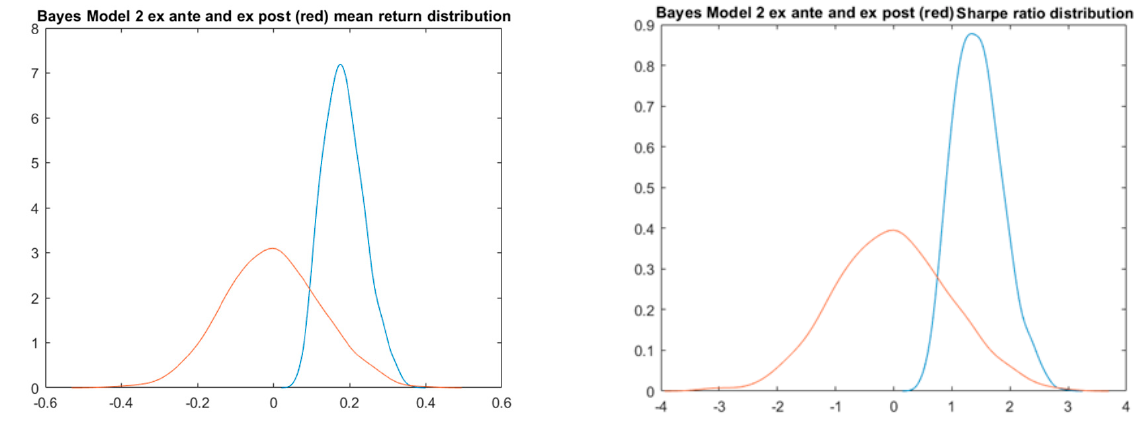
Figure 14. Bayes model 2 simulation of the ex ante (blue) and ex post (red) probability densities.